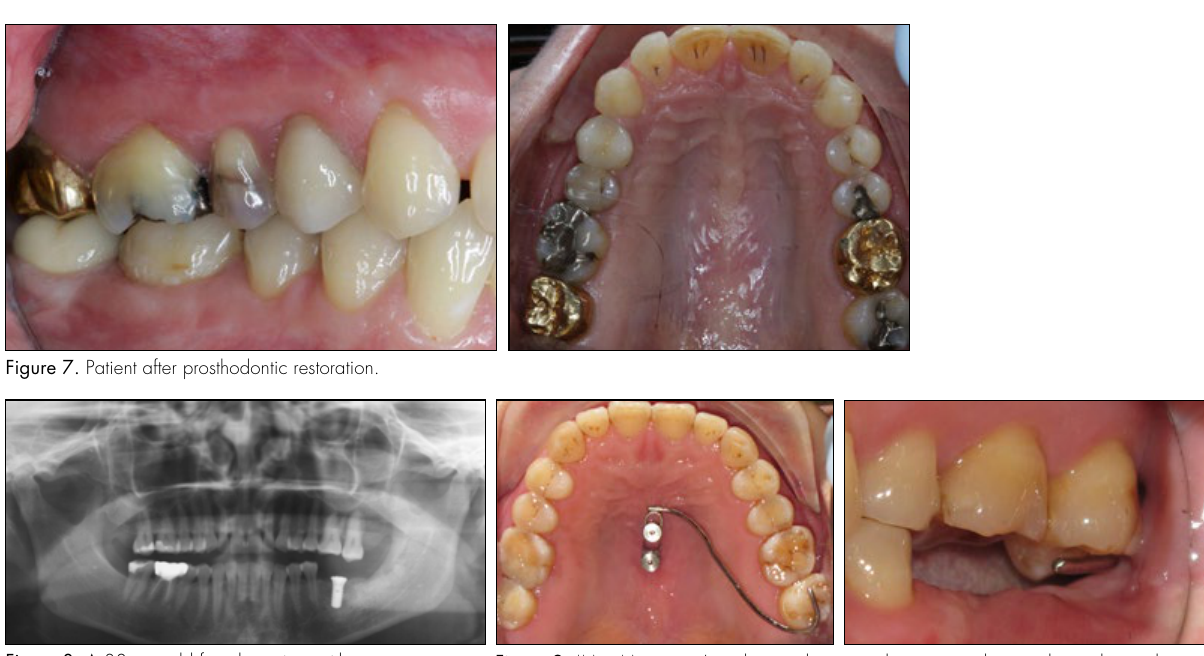
Fig.9b Figure 9. ‘Mini-Mousetrap’ in place with two median mini-implants in the palate palate